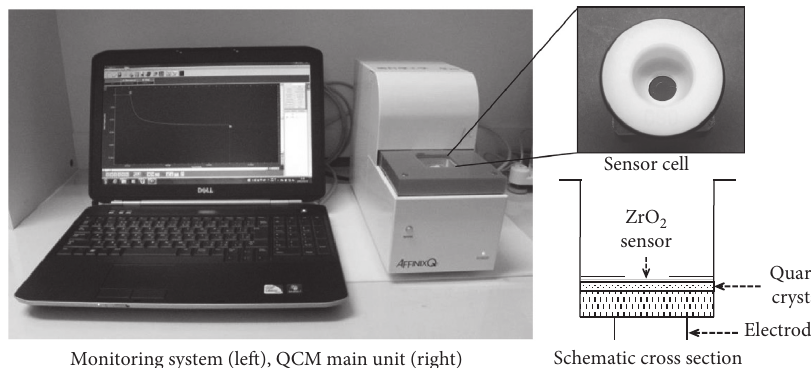
Figure 1: QCM devise and mounted sensor used in this